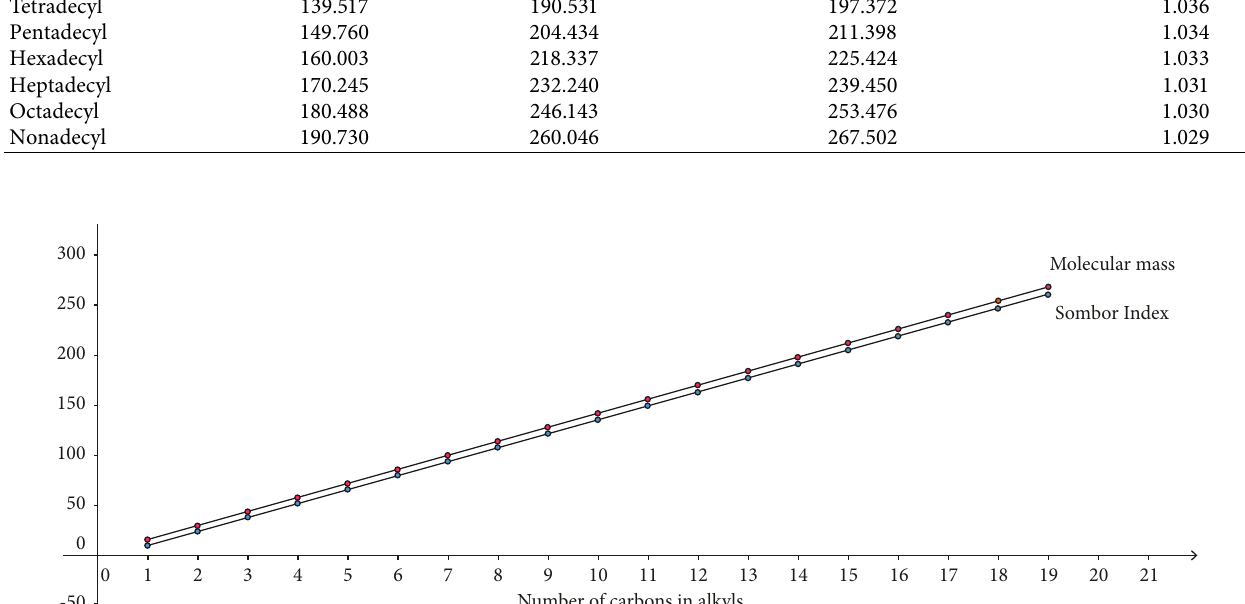
Figure 4: The Sombor index and molecular mass of nineteen alkyls with the correlation coefficient